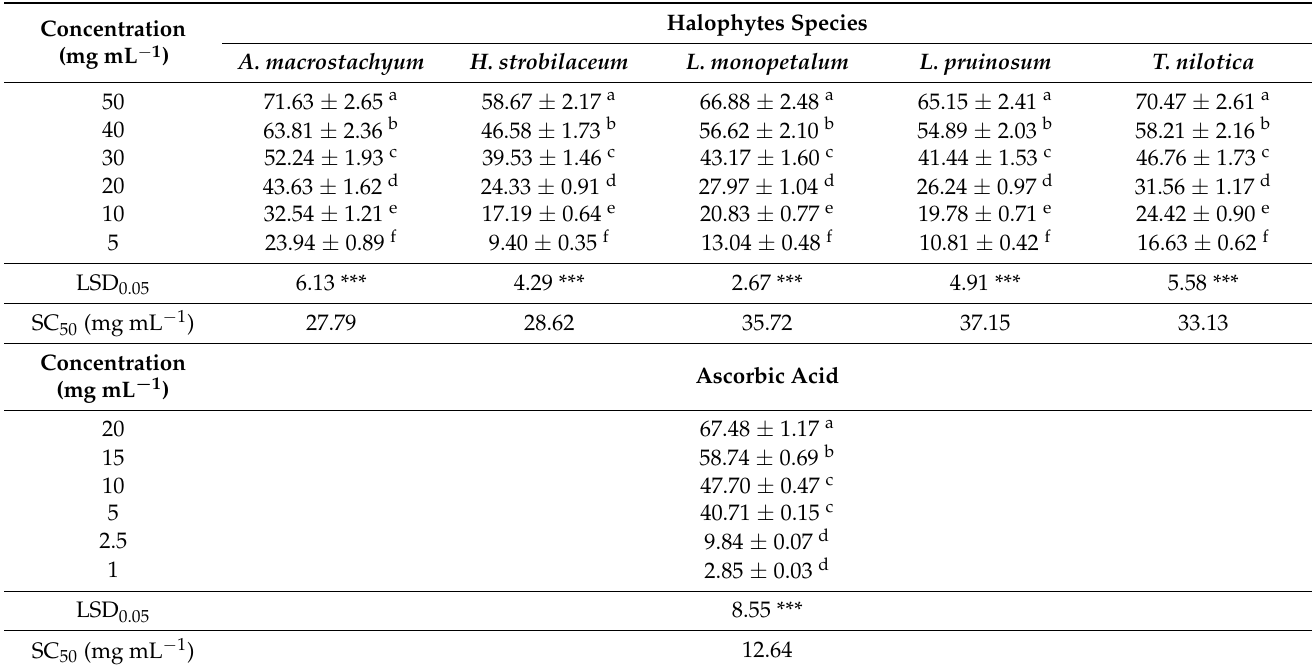
Table 4. Scavenging activity percentage of 2,2-Diphenyl-1-picrylhydrazyl (DPPH • ) and the SC 50 values by the methanolic extract of the five studied halophytes and ascorbic acid as